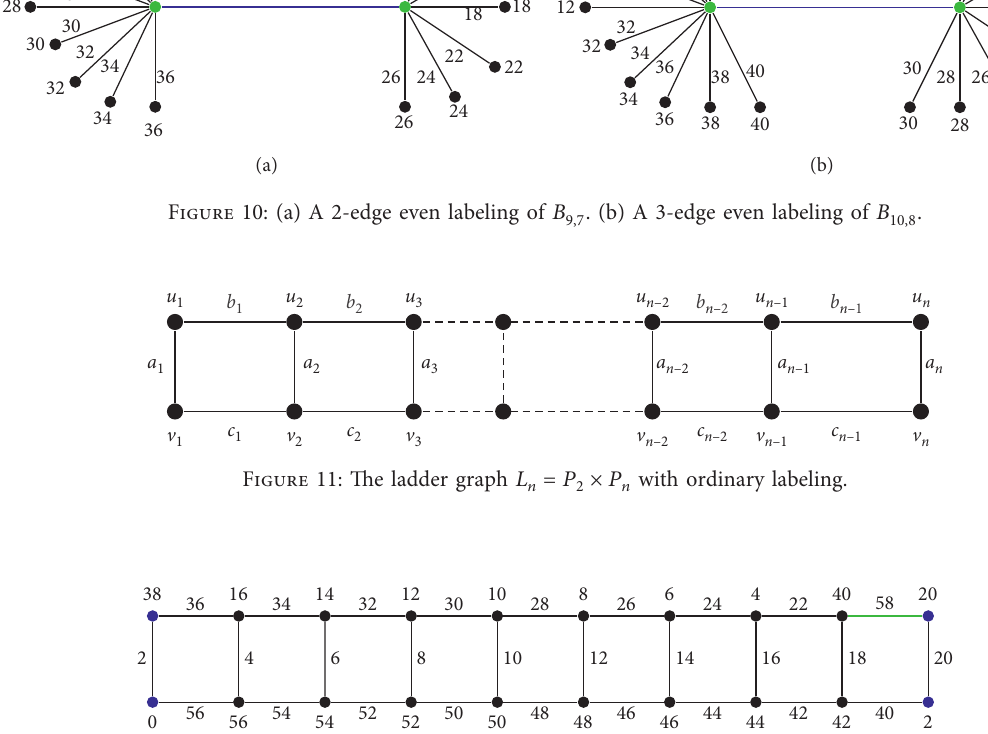
Figure 12: A 2-edge even labeling of the ladder graph L